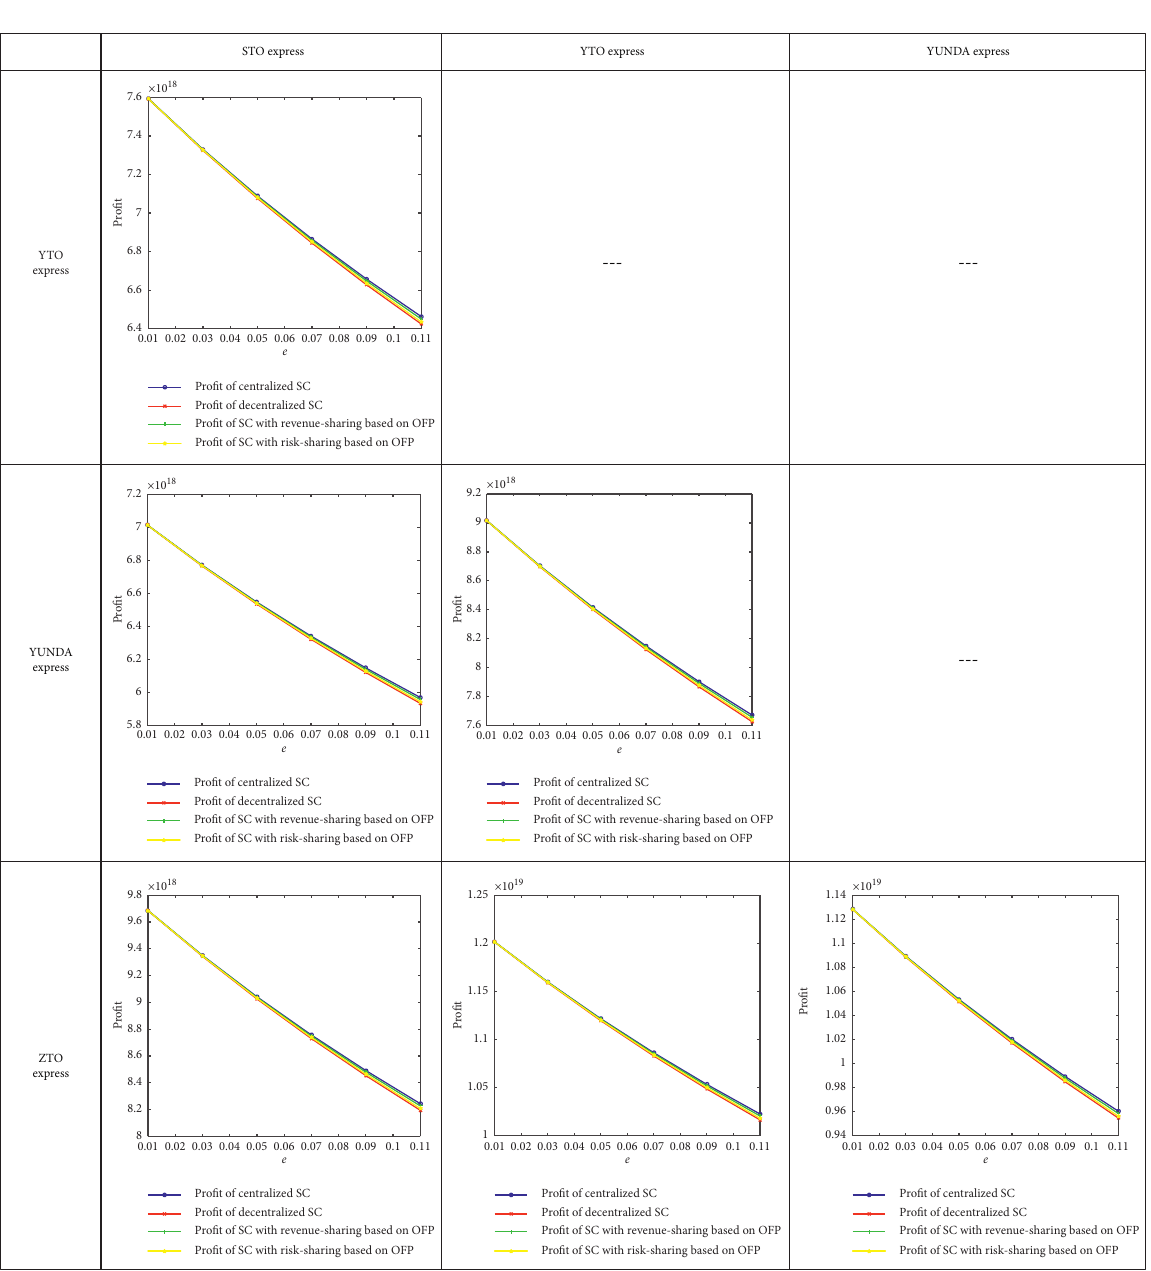
Figure 3: SC performance during the two-two cooperation on the change trends of nonscale economic cost e